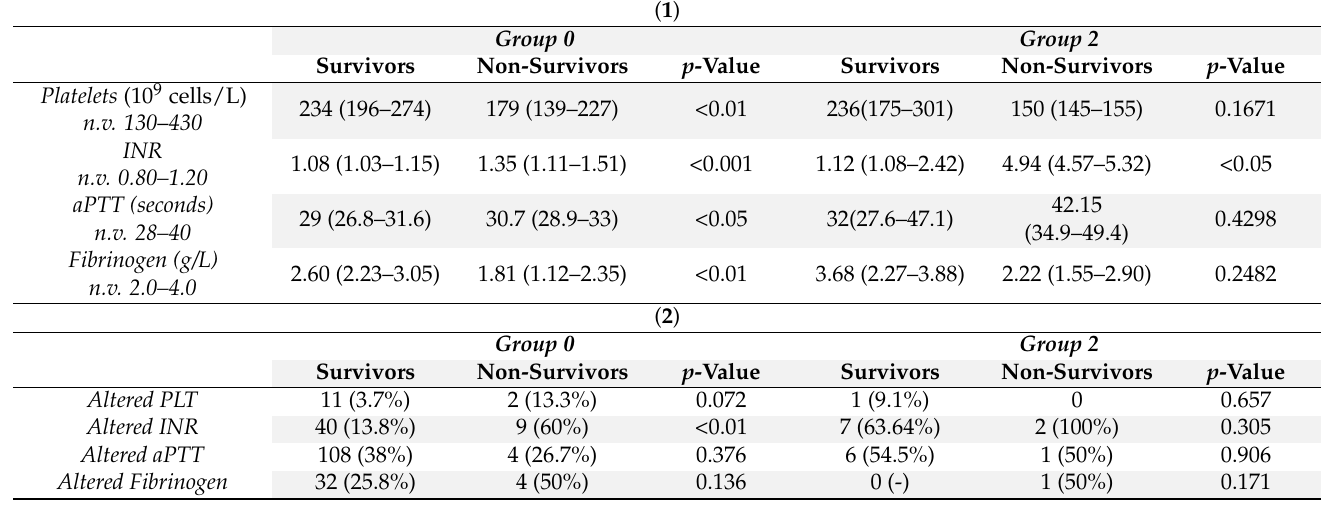
Table 2. ( 1 ) Clotting factors median and 25–75% IQR at admission and mortality in Group 0 and Group 2 (Group 1 values can be found in Table 1 as no deaths were found in this group). ( 2 ) Number of patients with altered clotting factors at admission and mortality in group 0 and group